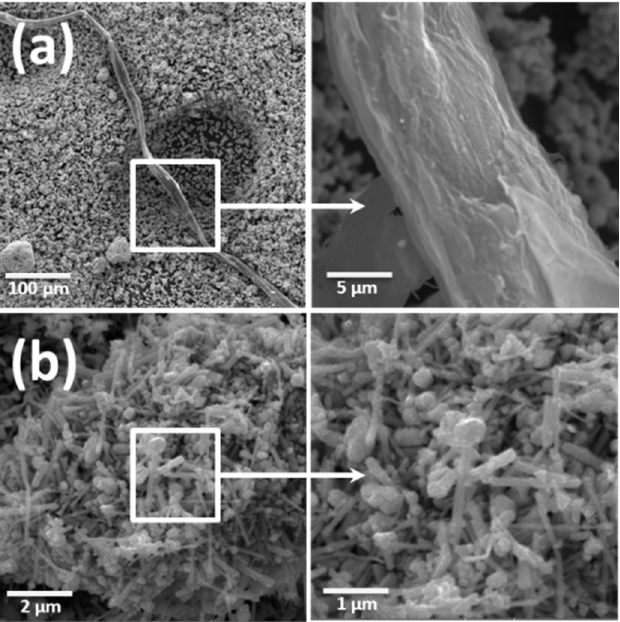
Figure 6. SEM images of silver nanowires: ( a ) Ag_NW; ( b ) Ag_NW_MW.